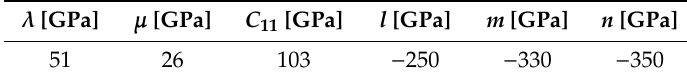
Table 3. Material constant used to numerical verification. Table 2. Two groups of applied stress setting for numerical simulation.